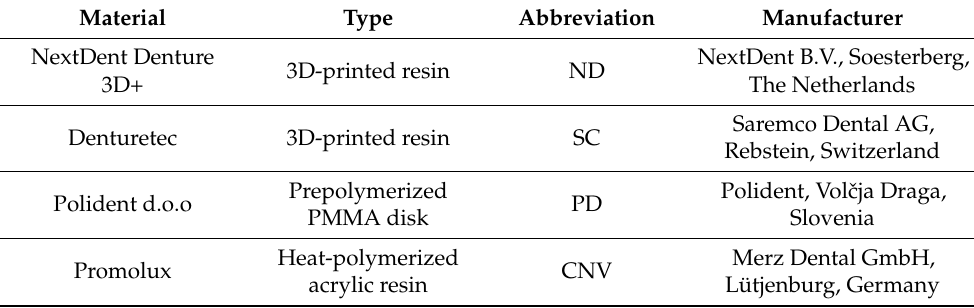
Table 1. Materials used in this